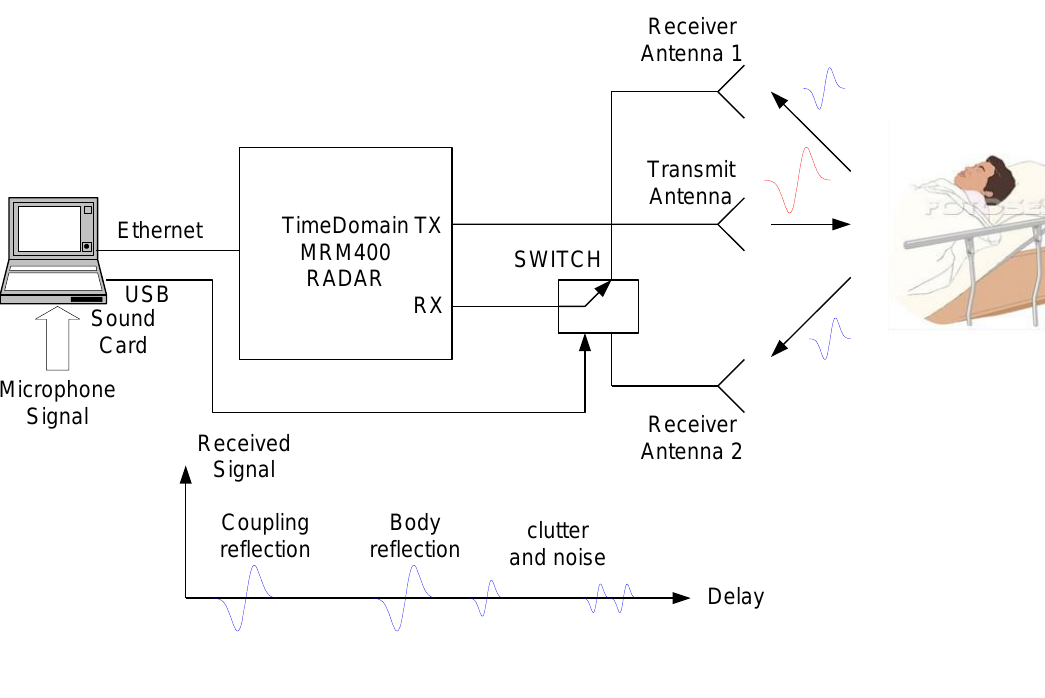
Figure 1. UWB radar test setup and